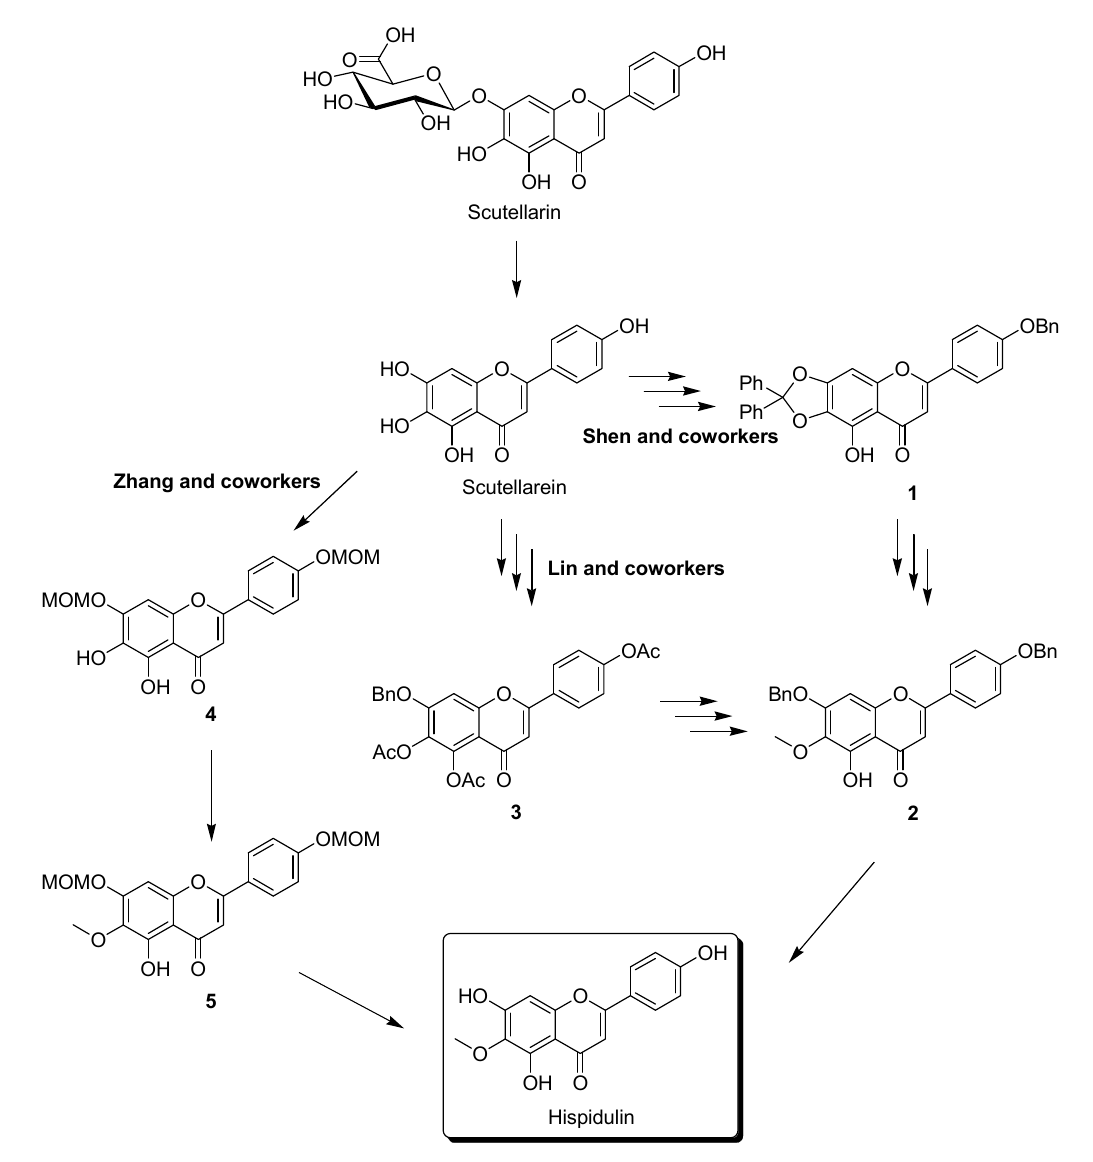
Scheme 1. Synthesis of hispidulin starting from scutellarin.